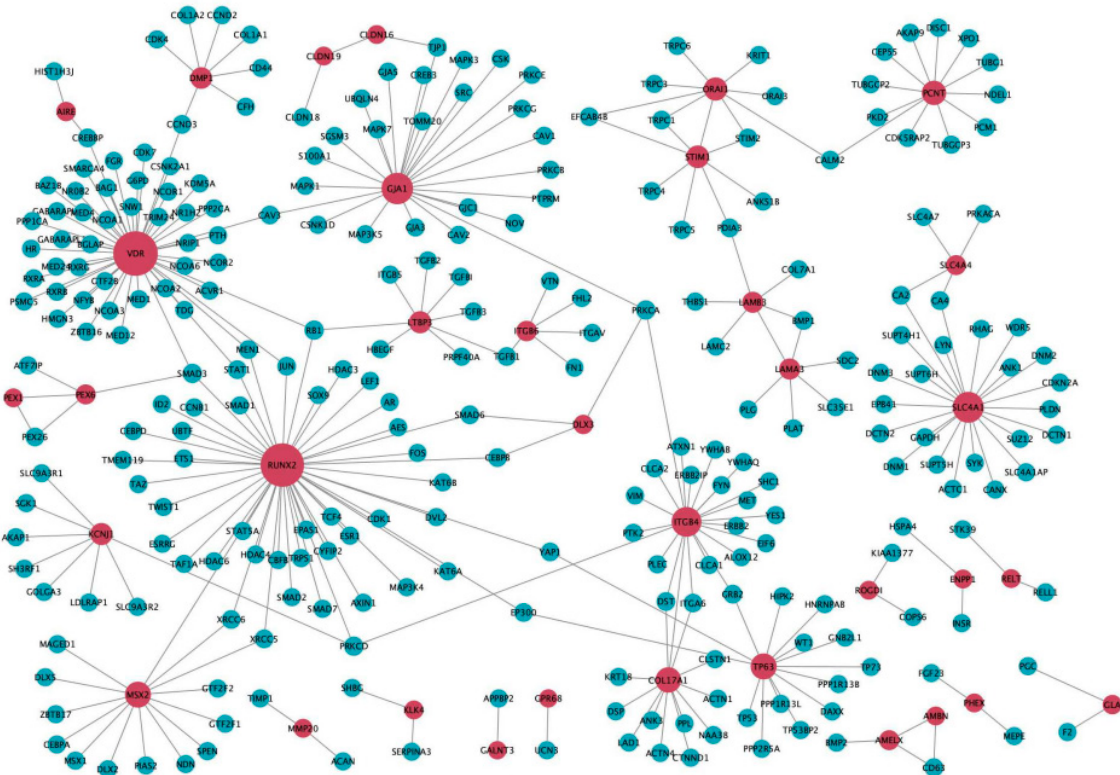
Figure 4. Protein–protein interaction (PPI) network of amelogenesis imperfecta-related genes. Red nodes represent amelogenesis imperfecta-related genes and blue nodes denote the genes that interact with amelogenesis imperfecta genes in the PPI network. The size of the nodes was ranked according to node degree. The PPI network we used here was a combination of all five